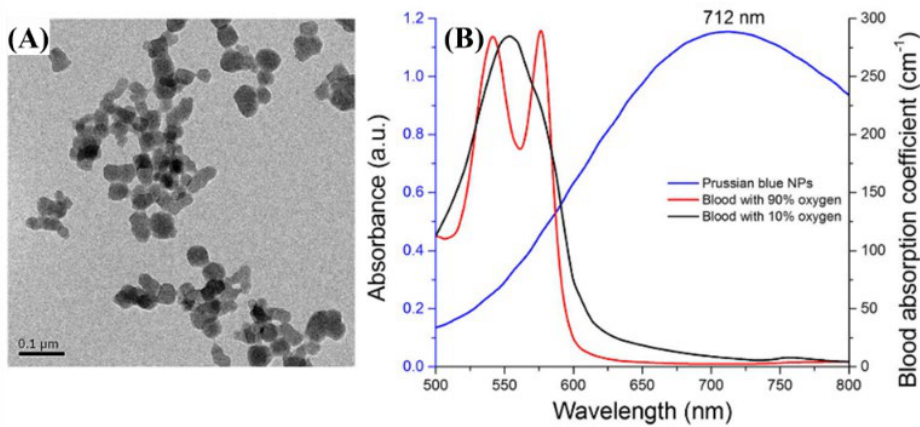
Figure 9. ( A ) TEM image of fabricated PB NPs. ( B ) Measured absorption spectra of PB NPs (blue) and optical absorption coefficients of blood with 90% (red) and 10% (black) oxygen saturation adapted from Prahl 37 and Kollias et al. Reprinted from Bui et al., Sci. Rep., 2016, 8,1: 018-20139-0 [26], with permission of Spring Nature.